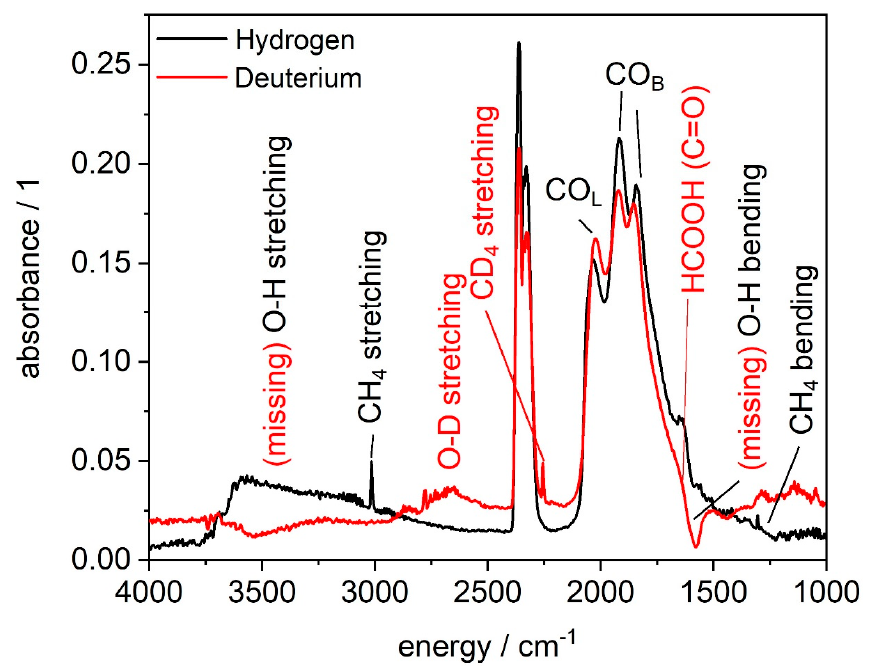
Figure 3. DRIFTS spectra of Ni on alumina / silica under methanation conditions using CO 2 plus hydrogen (black curve) and deuterium (red curve), respectively.